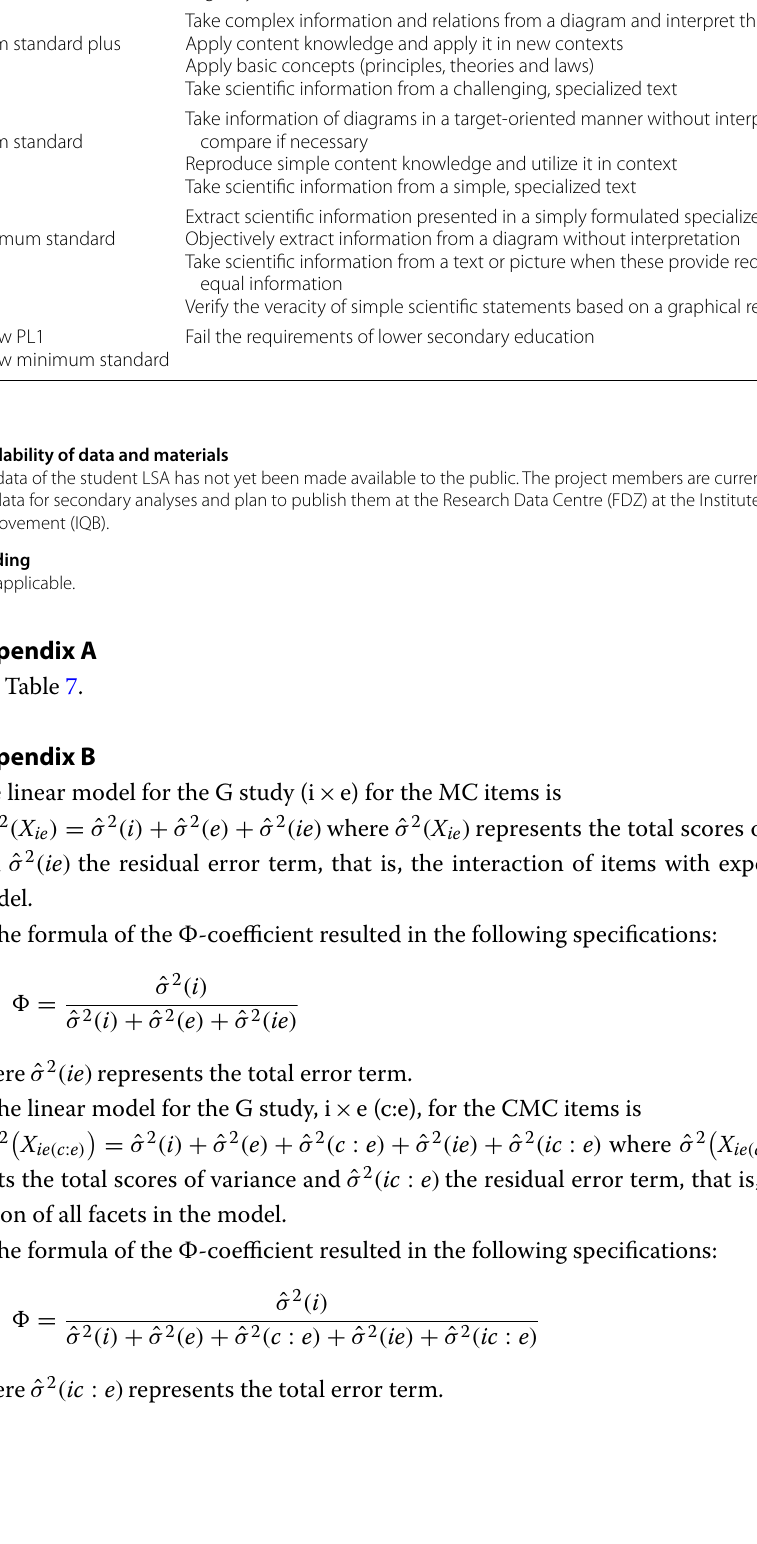
Table 7 Proficiency level descriptions PL4 Optimal